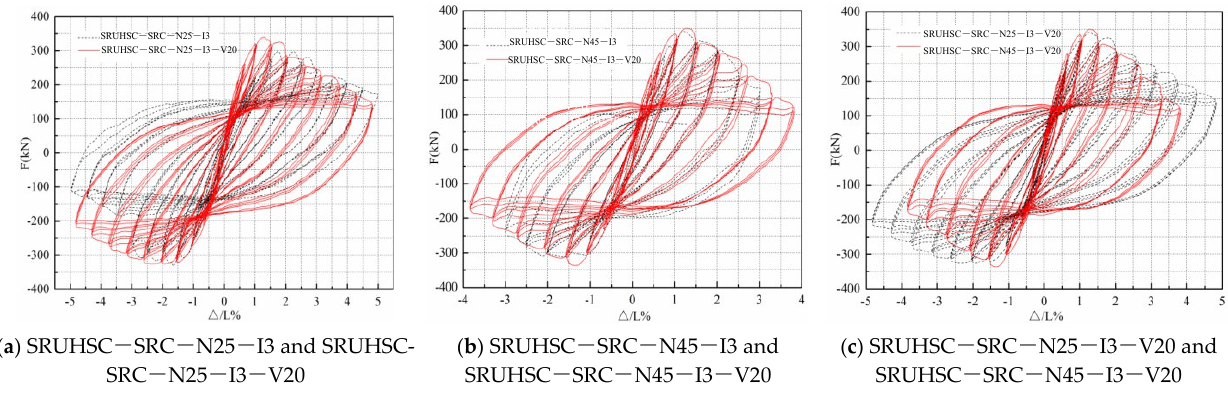
Figure 6. Comparison of the hysteresis